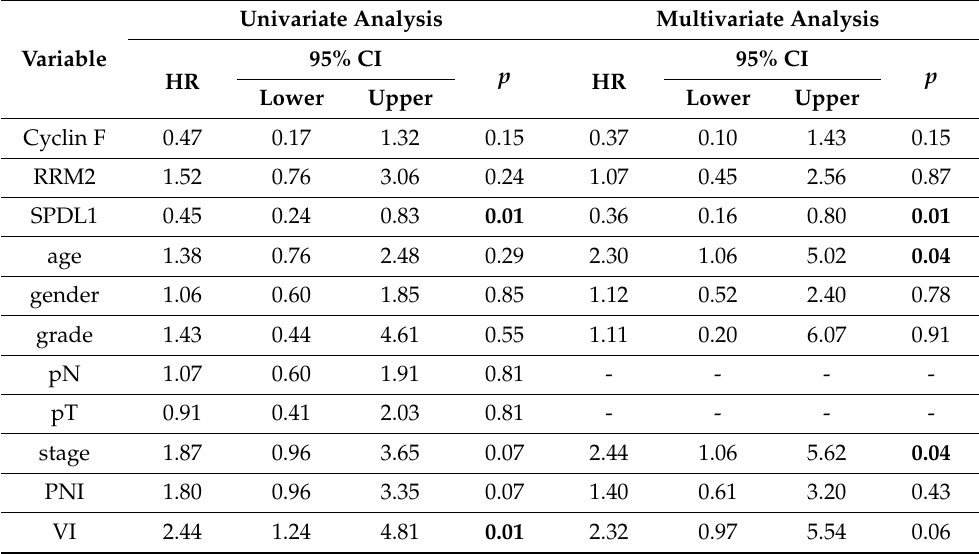
Table 4. Univariate and multivariate Cox proportional hazards models for OS of PDAC patients ( n = 62). Univariate Analysis Multivariate Variable